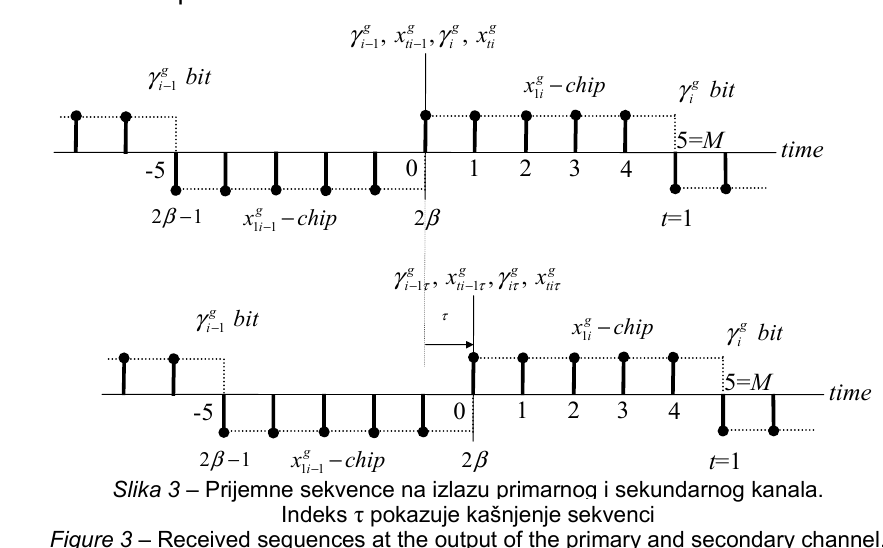
Figure 3 – Received sequences at the output of the primary and secondary channel. The index τ represents the delay of the